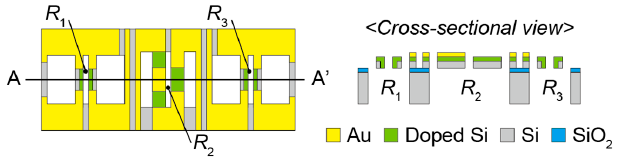
Figure 3. Design of the sensor chip.